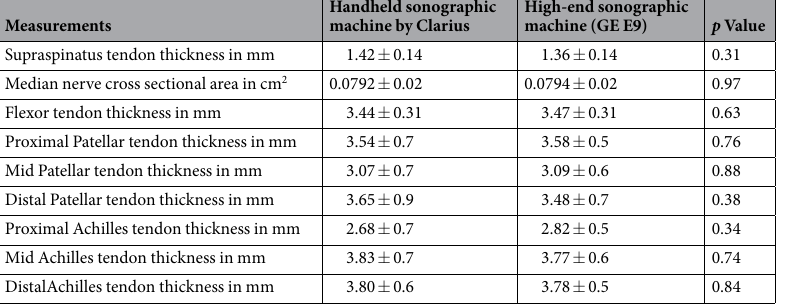
Table 1. Mean value of measurements of the thickness of 42 supraspinatus, 42 flexor, 42 patellar and 42 Achilles tendons and of the cross sectional area of 42 median nerves obtained with the handheld and high-end sonographic machines and their statistical comparison.